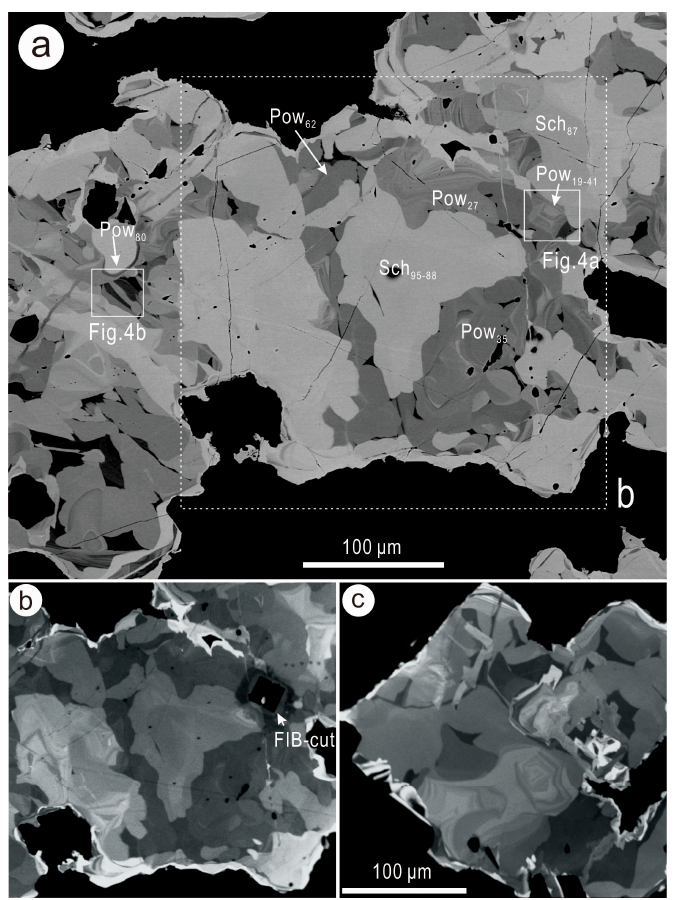
Figure 3. BSE image ( a ) and cathodoluminescence (CL) images ( b , c ) showing textures and growth zones in aggregates of scheelite-powellite (Sch-Pow). ( a ) The aggregate consists of W-rich domains (brighter), weakly- or un-zoned with garlands of smaller, Mo-rich, oscillatory-zoned grains. There are however, Mo-rich areas that lack zonation and also thin slivers with strong-contrast, oscillatory zoning (arrowed). ( b , c ) CL images show growth zones in W-rich domains with strong contrast along the rims suggesting REE-enrichment. Chaotic patterns are shown in ( b ), whereas crystal oscillatory zoning is revealed in ( c ).